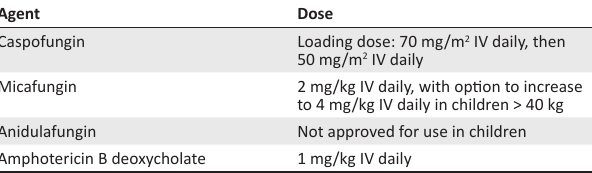
TABLE 7: Antifungal agents for children younger than or equal to 2 months of age with invasive disease. Agent